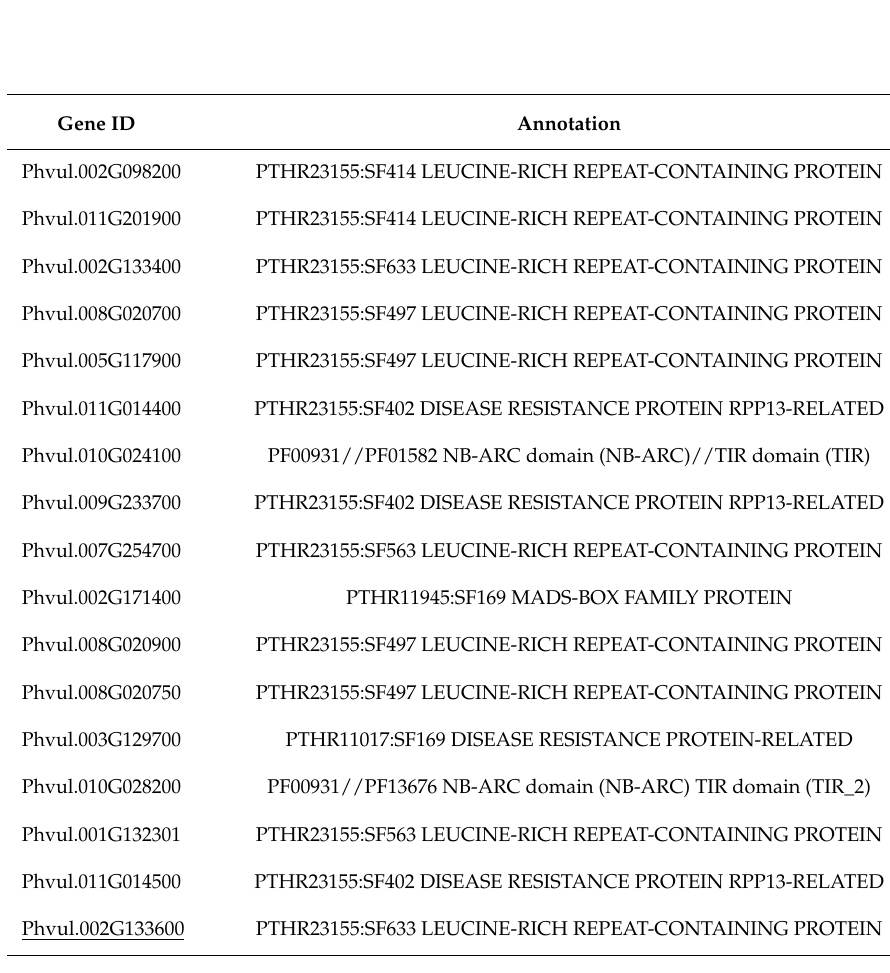
Incompatible Compatible C531 vs. Mock 48